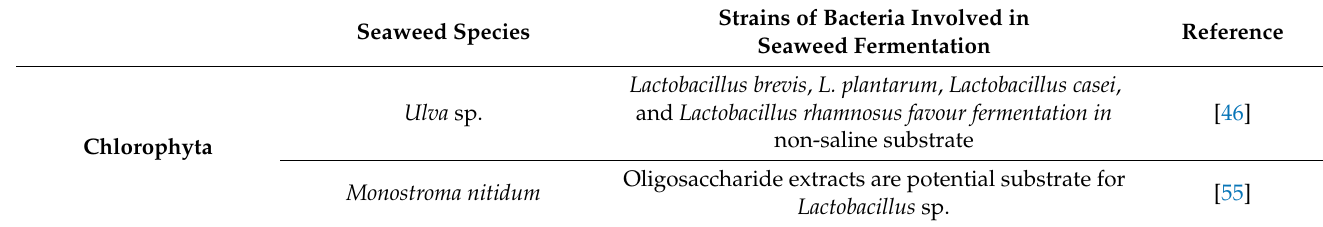
Table 1. Seaweed species investigated as fermentation substrate. Strains of Bacteria Involved Seaweed Species